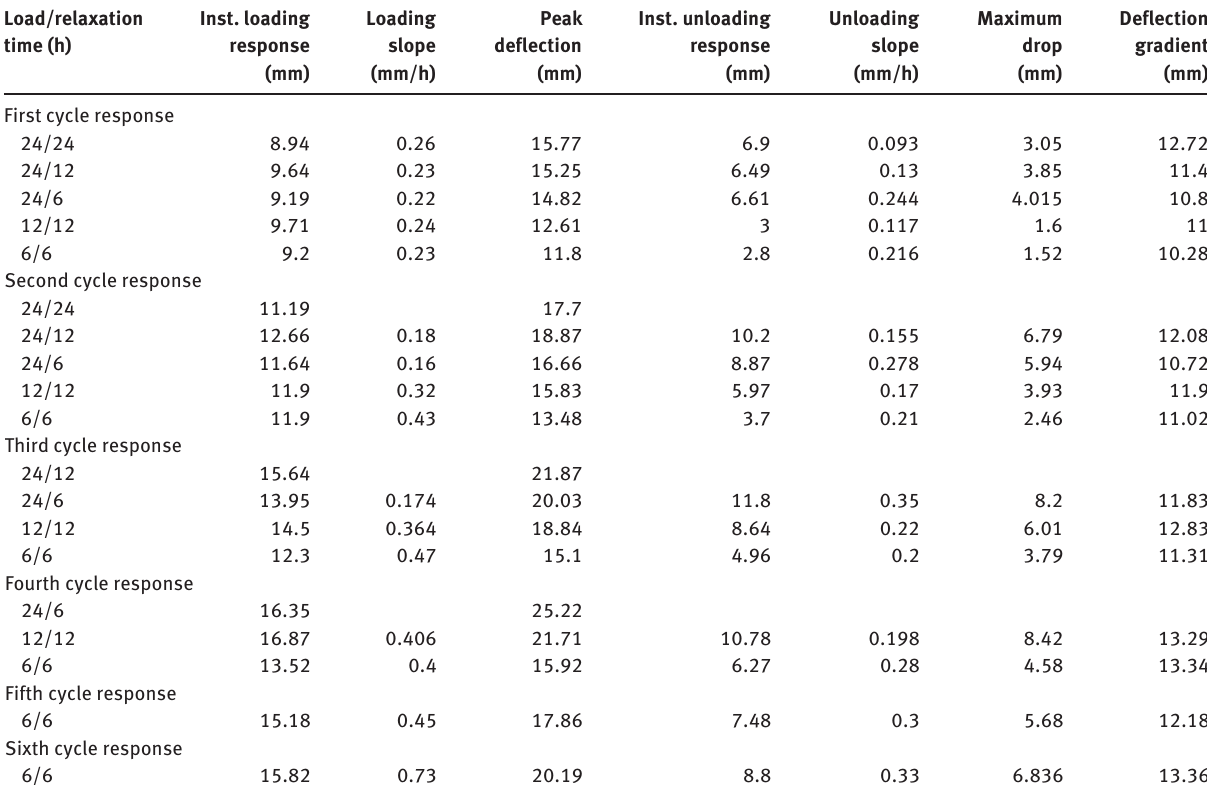
Table 2: Analysis of load – relaxation (R = 1) cyclic creep